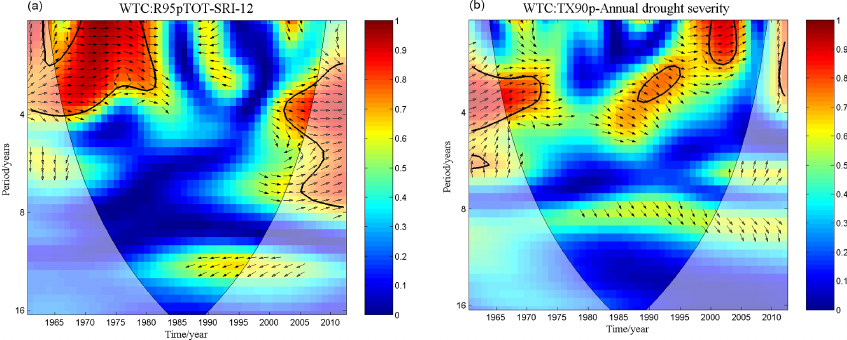
Figure 5. Squared wavelet coherence spectrum (a) between the R95pTOT (i.e. (R95p/PrcpTOT) × 100%) and SRI-12 based on simulated runoff; and (b) between the TX90p (warm days) and annual drought severity based on SRI-12. The 5% significance level against red noise is shown as a thick contour. All significant sections show in-phase